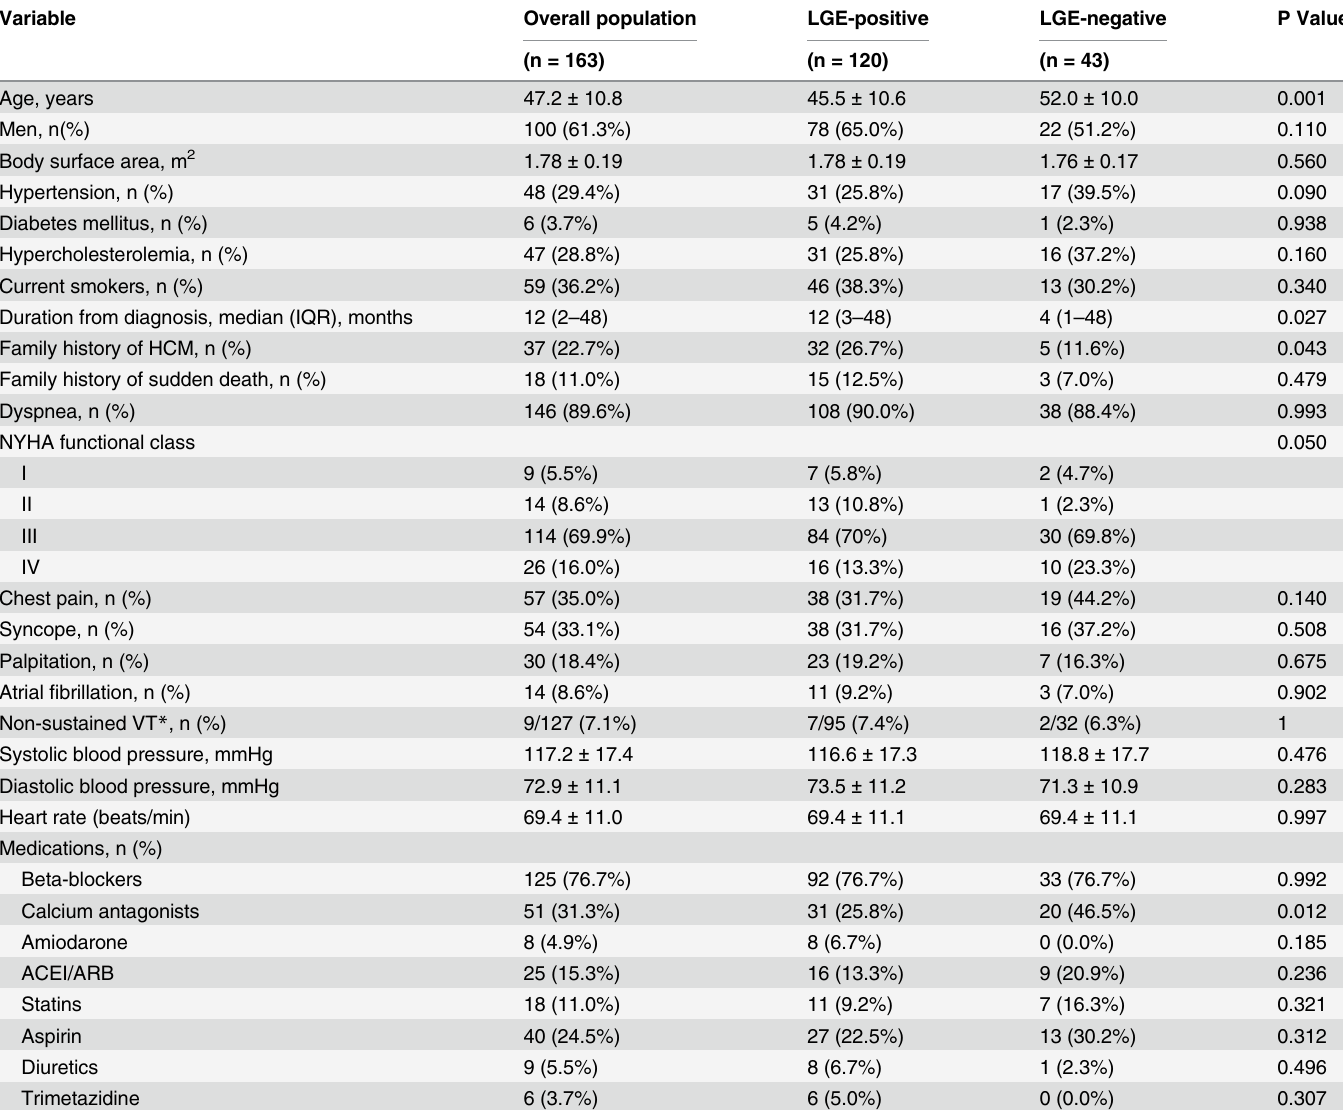
Table 1. Baseline characteristics of patients with and without